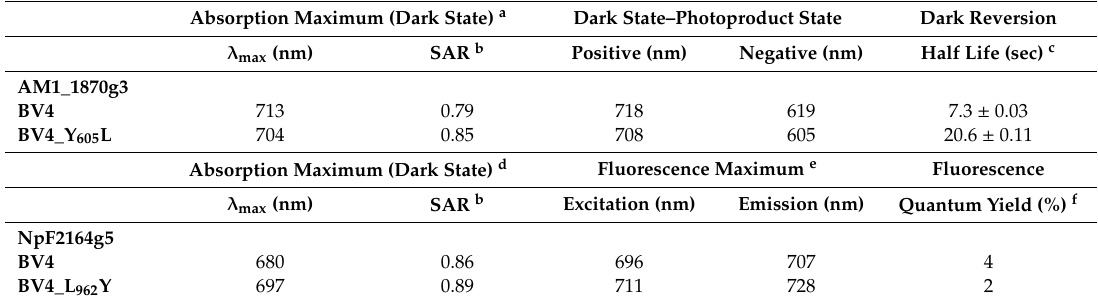
Biochemical and photochemical properties of BV-bound AM1_1870g3_BV4 and NpF2164g5_BV4